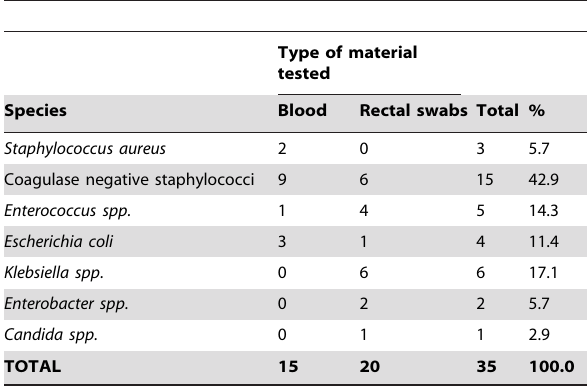
Table 2. Microorganisms isolated from blood or rectal swabs of neonates with NEC.